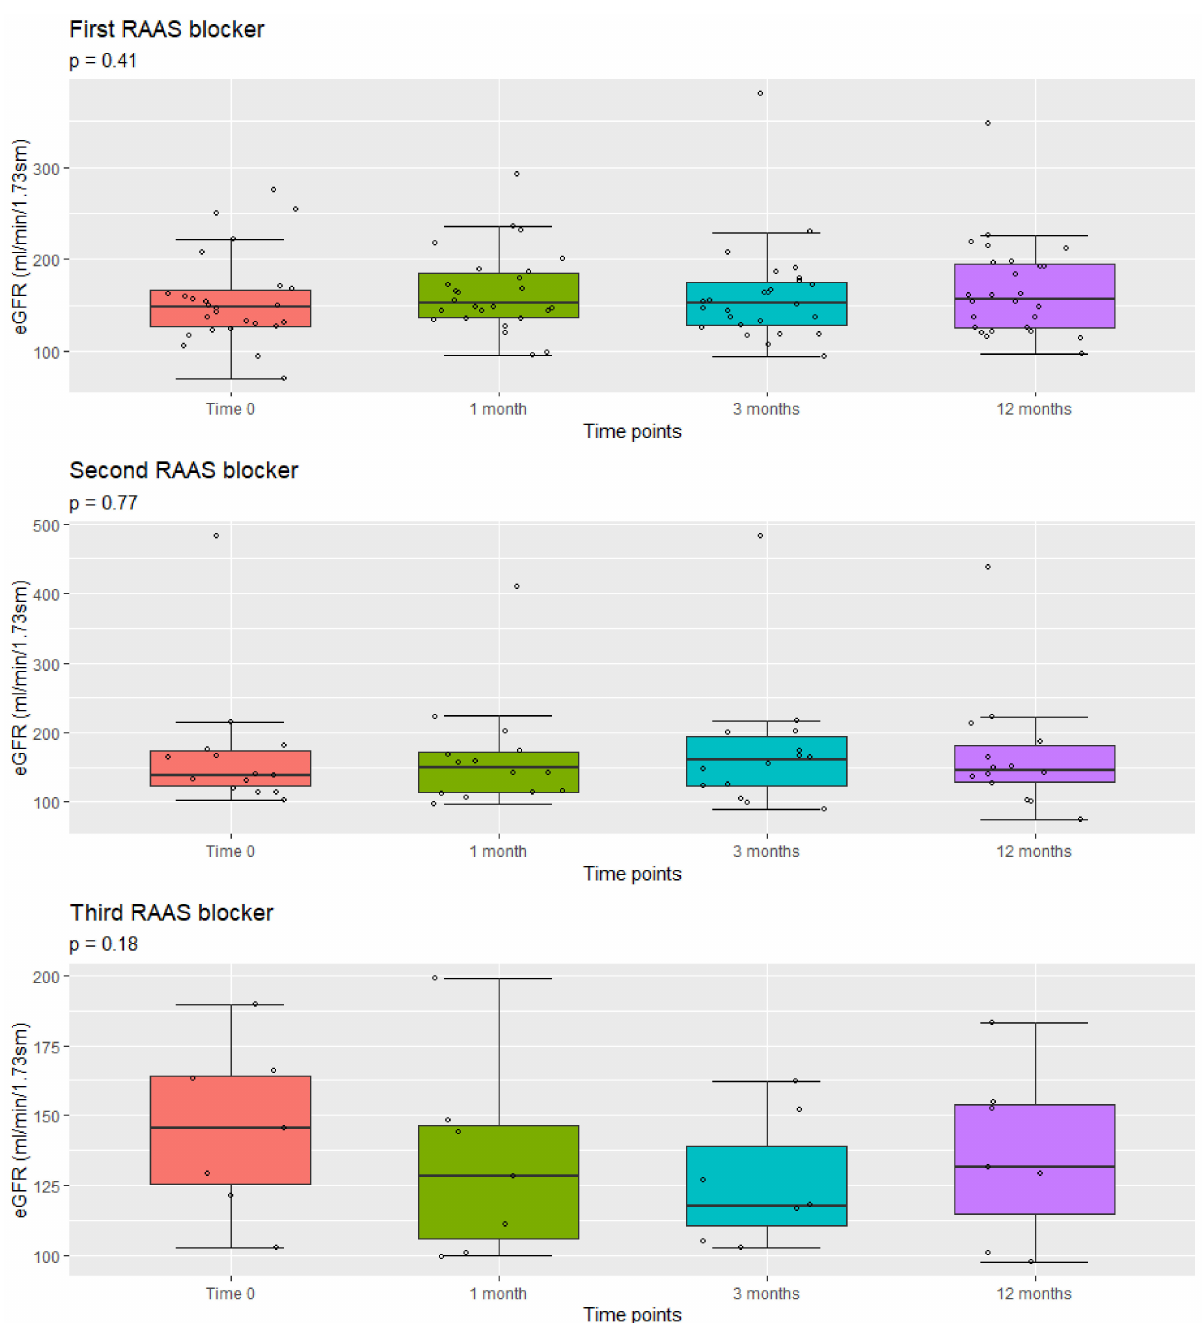
Figure 3. Boxplots of the distribution of eGFR values at different time points from the introduction of the first, second, and third RAAS blocker. All p values are from Repeated Measures Anova analysis of log-transformed data. The measured values are represented by